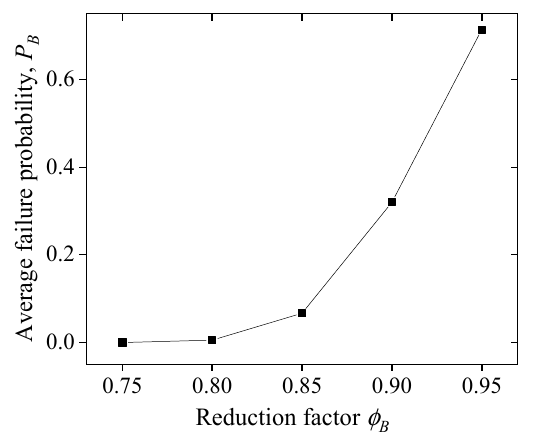
Figure 18. Effect of the reduction factor on the average failure probability, P B.